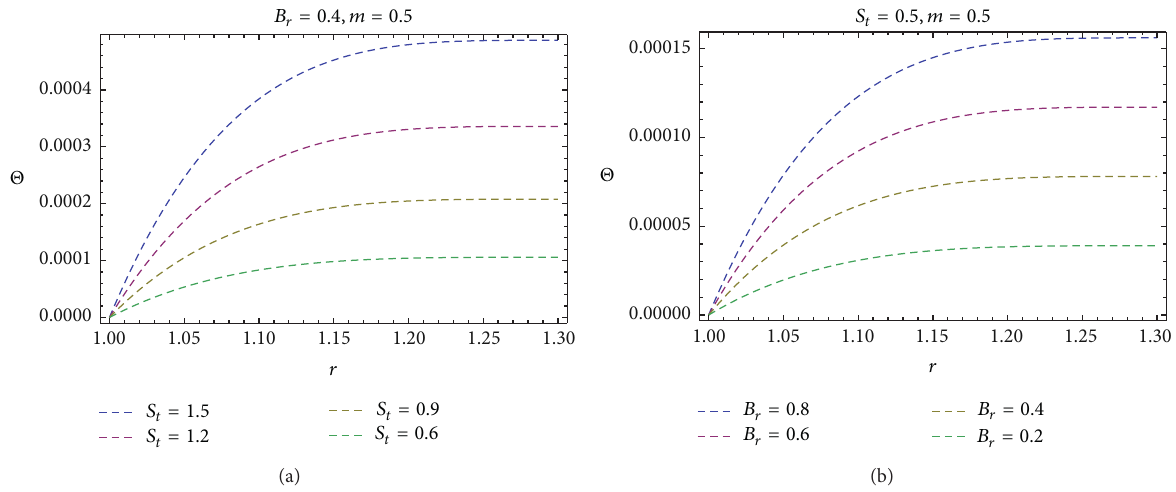
Figure 6: Effect on shear thickening fluid of 𝑆 𝑡 and 𝐵 𝑟 numbers on temperature for both problems.